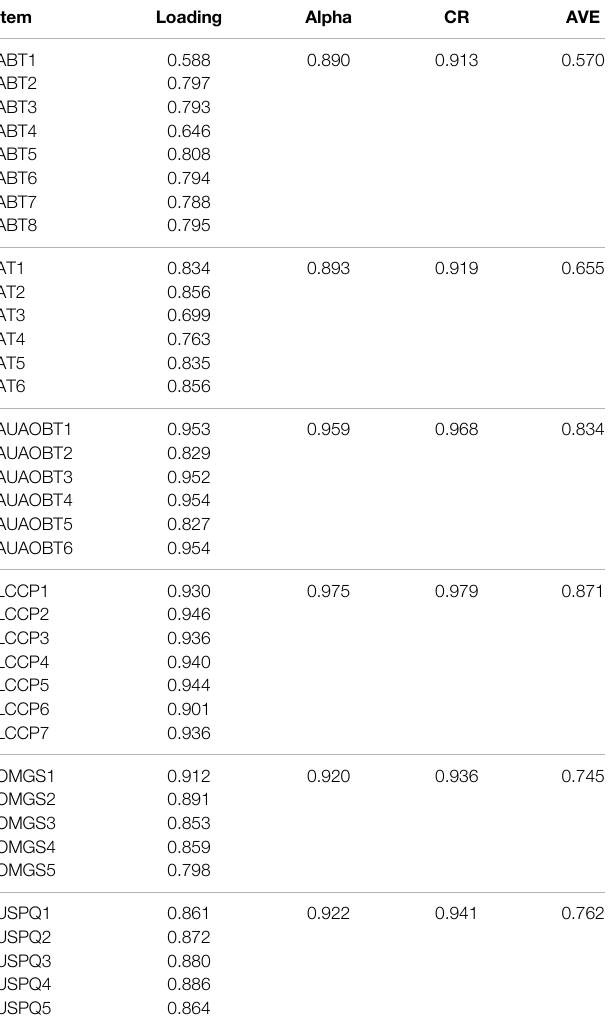
TABLE 4 | Cross-loading.